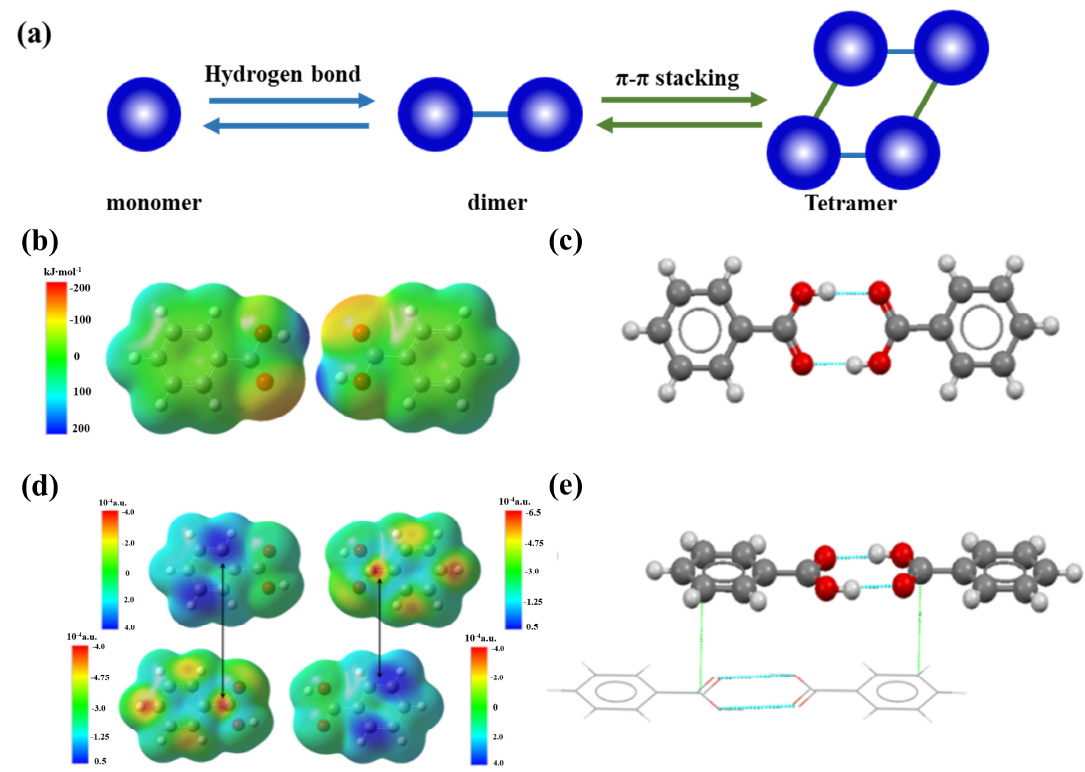
Figure 9. Hierarchical self−assembly of benzoic acid molecules in solution dictated by multiple in- termolecular interactions: ( a ) higher−order self−assembly pathways in the pre−nucleation stage. ( b ) Electrostatic potential of benzoic acid molecules with hydrogen−bonding interactions. ( c ) Hydro- gen−bonded dimer motif. ( d ) Nucleophilic and electrophilic Fukui function mapped on the van der Waals surface. ( e ) Hierarchical tetramer motif [35]. Reprinted/adapted with permission from [35].